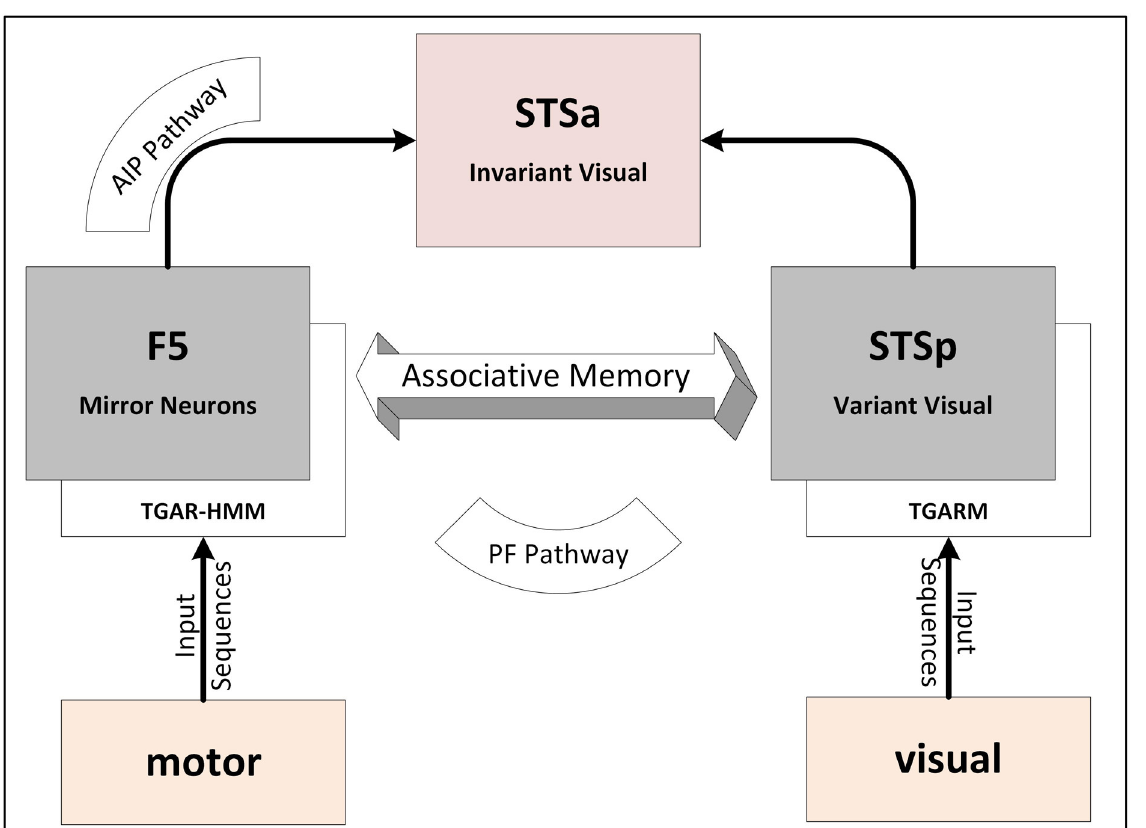
Fig 2. Computational model of the mirror neuron